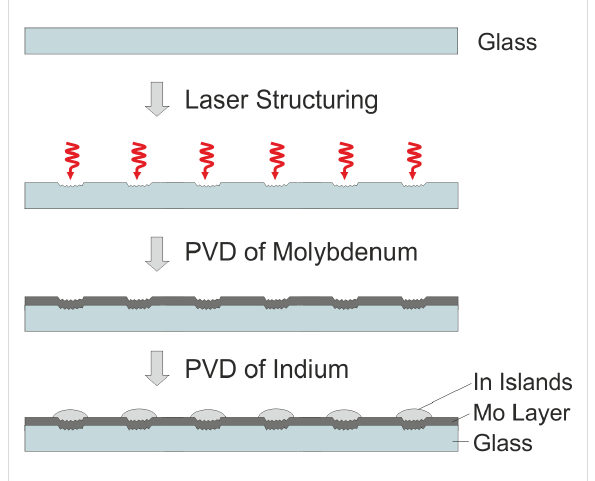
Figure 3: Schematic representation of ordered indium island growth on fs-laser structured, molybdenum-coated glass. Reprinted with permission from [17], copyright 2017